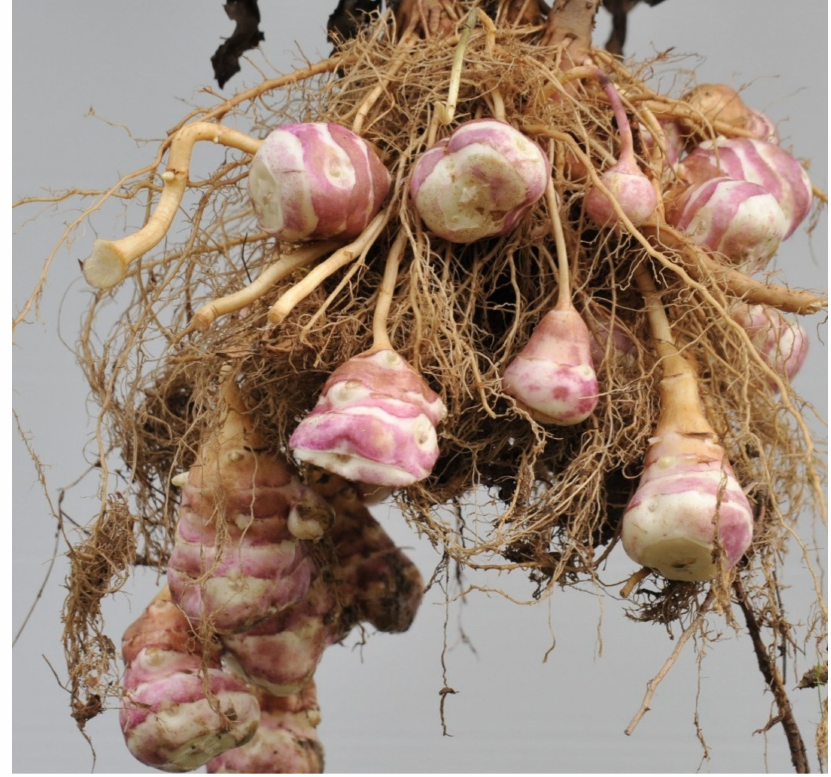
Figure 2. Tubers, stolons, roots, and rhizomes of the ‘Rubik’ cultivars of H. tuberosus. Source: own